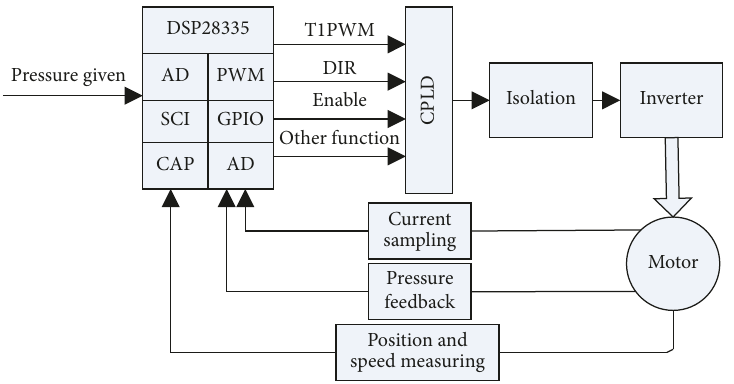
Figure 10: The hardware of HILS.